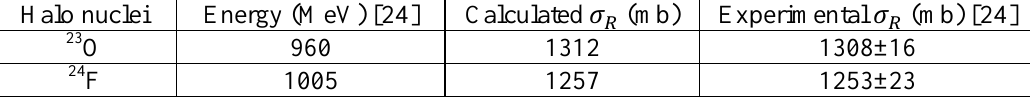
Table 5: Calculated and experimental